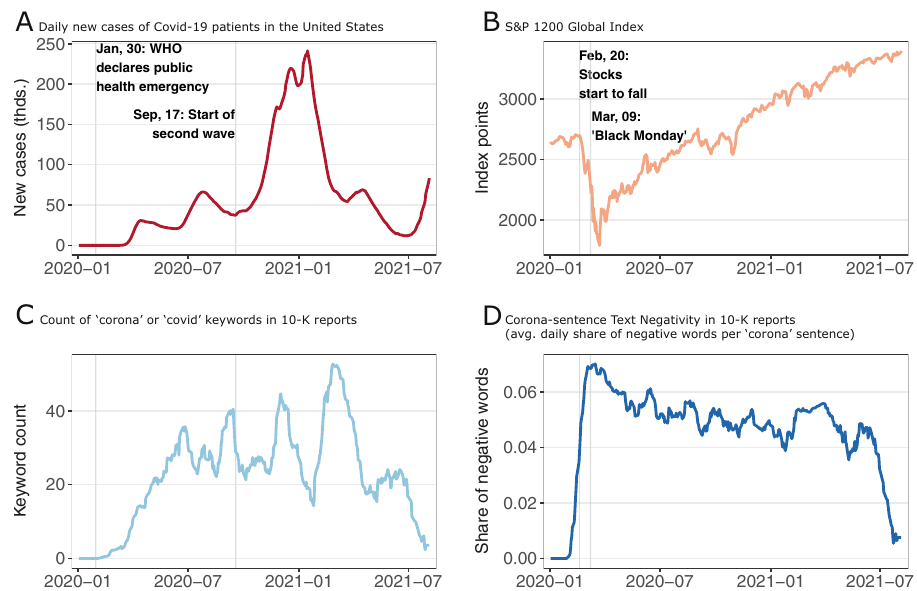
Fig. 1 The CoRisk measures re fl ect economic concerns with regards to Covid-19 since early 2020. A Daily cases of Covid-19 infections in the United States (source: www.ourworldindata.org): the fi rst wave of the pandemic started in March 2020, the second in September. B S&P 1200 Global Index (source: www.spglobal.com): As the Covid-19 pandemic reaches the level of a global health crisis, stock markets plummet on 20th February but recover sharply from April 2020 onward. C Number of ‘ corona ’ keywords in 10-K reports: the number of reports about the virus starts to rise before the fi rst wave and the measure shows oscillating behaviour with peaks in June, September and December 2020. D Share of negative words in ‘ corona ’ sentences of 10-K reports: The negative sentiment surges before the global stock market crash and peaks before ‘ Black Monday ’ s ’ most severe stock market